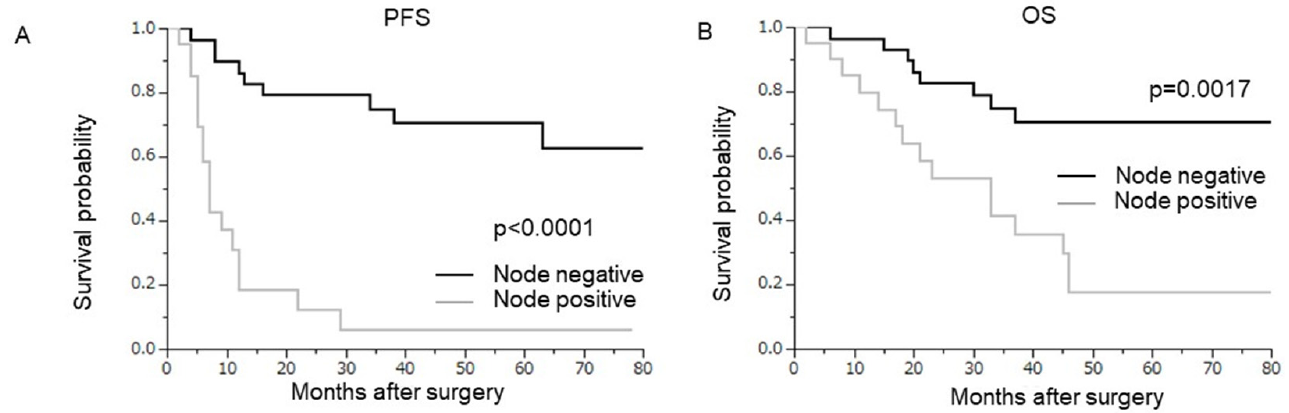
Figure 1. Prognostic significance of lymph node metastasis. Kaplan–Meier estimates of progression- free survival or overall survival according to lymph node status (node-negative ( n = 29) vs. node- positive ( n = 21)). ( A ) Progression-free survival (node-negative vs. node-positive; p < 0.0001). ( B ) Overall survival (node-negative vs. node-positive; p = 0.0017).